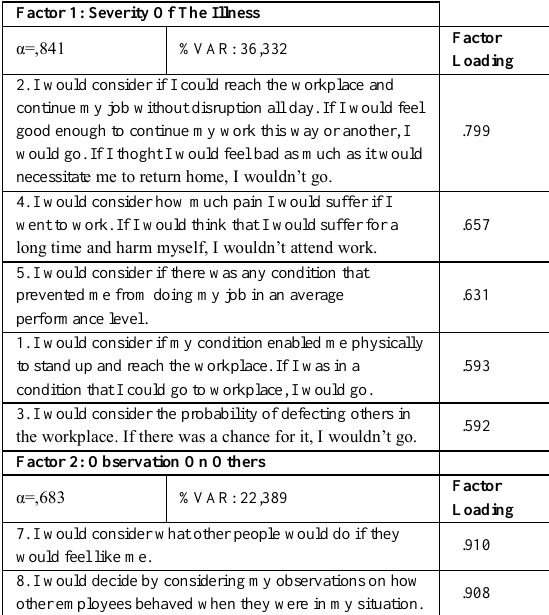
**Correlation is significant at the 0.01 level (2-tailed). * Correlation is significant at the 0.05 level (2-tailed).